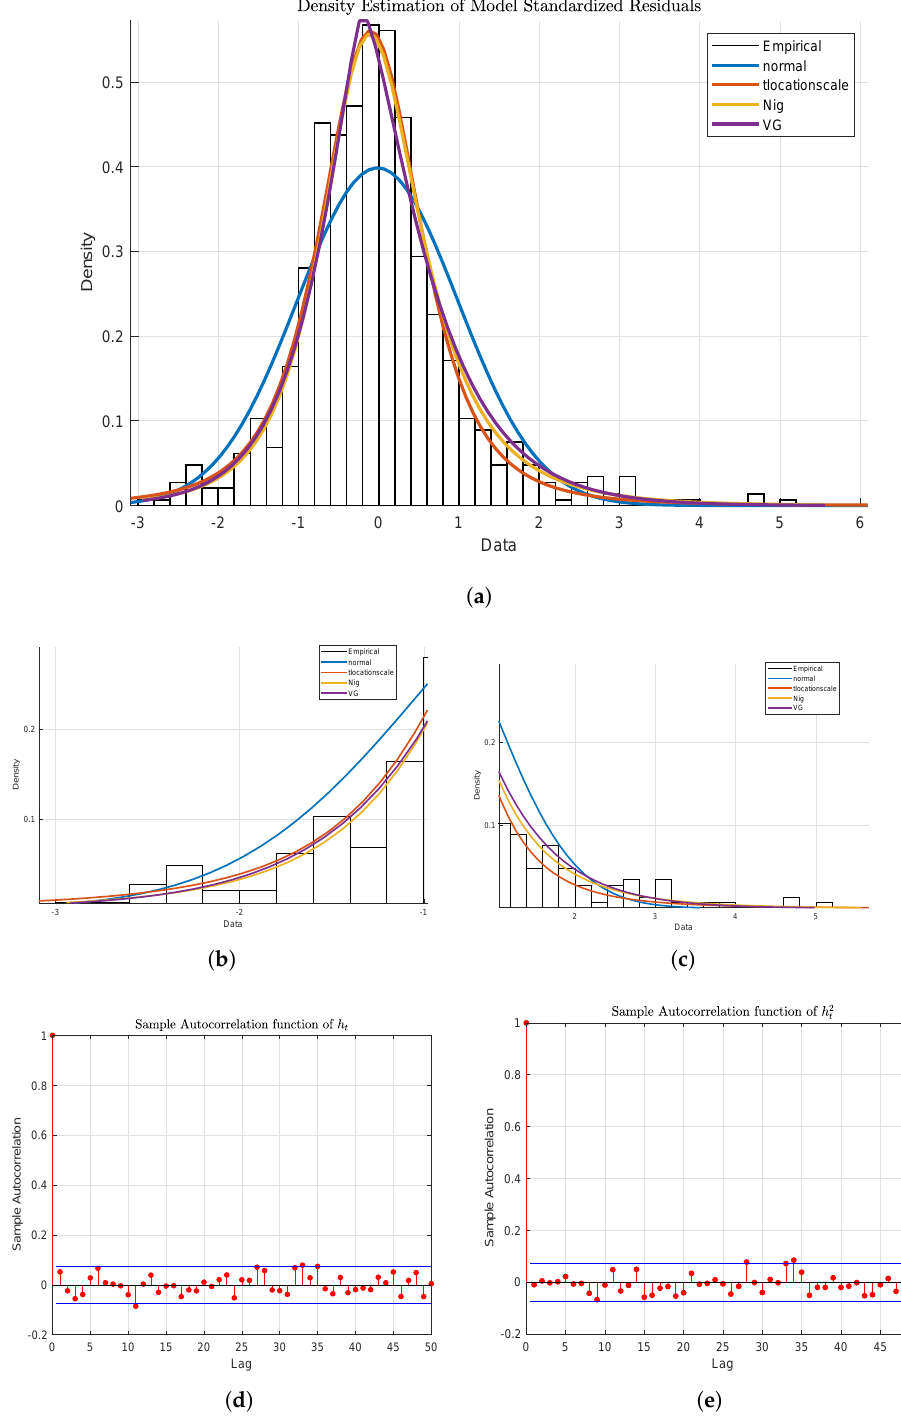
Figure 12. Density estimation of standardized model residuals, panel ( a ), and the two tails magnified, panels ( b , c ). The two graphs in panels ( e , f ) represent sample autocorrelation functions of the standardized residuals h t and h 2 t